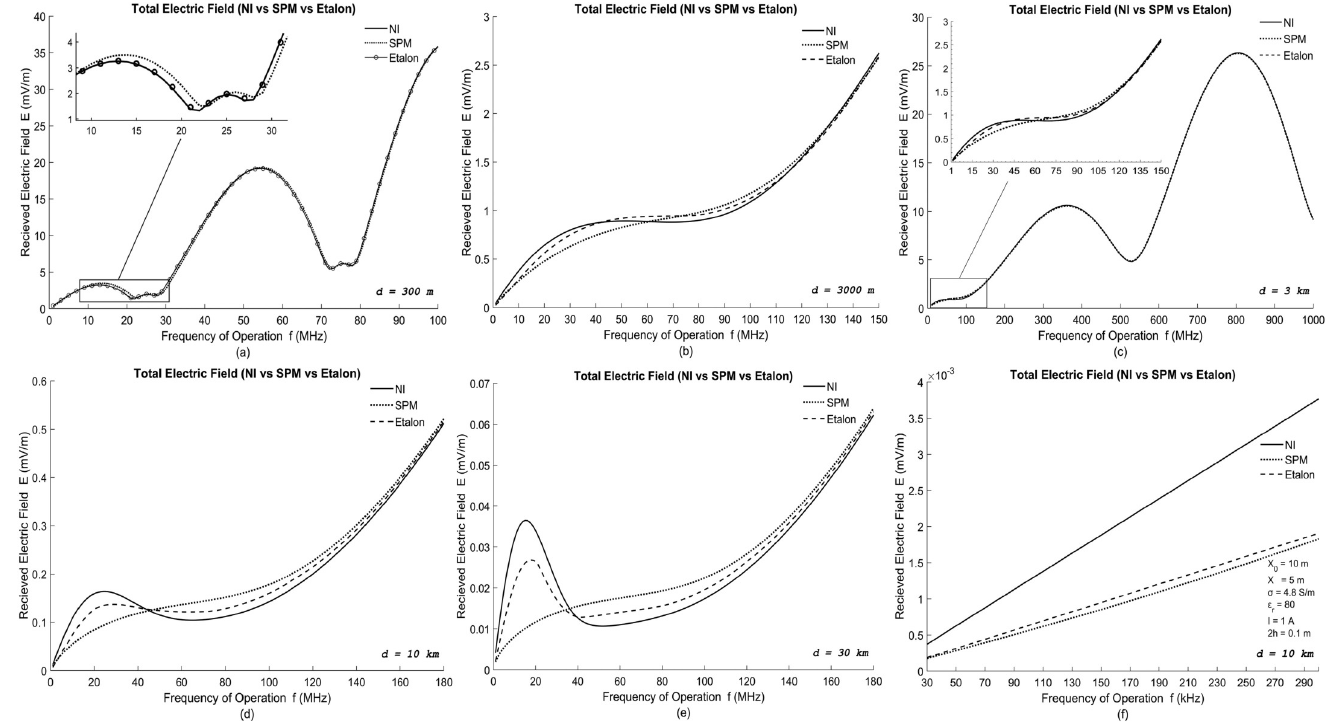
Figure 8. The variation in the total received electric field (magnitude) with respect to frequency ( f ) over various horizontal distance ( d ) scenarios (sub-figures a – f ), as predicted by (i) numerical integration of (18) and (19)—“NI”, (ii) the SPM-based asymptotic solution of (18)—“SPM”, and (iii) the Etalon-based asymptotic solution of (20)—“Etalon”. Simulation parameters are given in Table 2, except for those explicitly mentioned in the legends of the respective